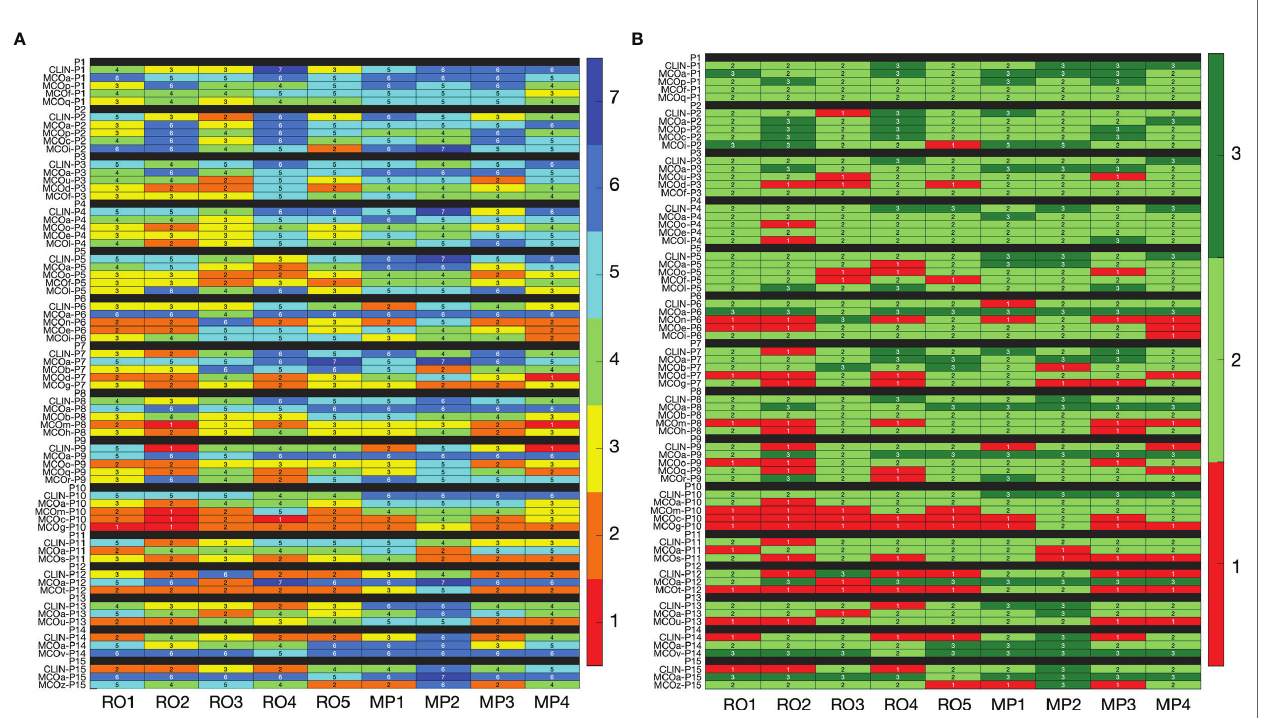
FIGURE 2 | (A) Heatmap visualization for raw plan quality scores (1 – 7, with 7 indicating the highest quality) of the nine observers (x-axis) for all 65 included plans (y- axis). (B) Heatmap visualization for category scores derived from the raw scores. In panel B, the color red indicates that the plan is considered unacceptable (category 1, raw scores 1 and 2), while light and dark green (category 2 with raw scores 3 – 5, and category 3 with raw scores 6 and 7) indicate that the plan is in principle acceptable. In the binary scoring system, red has binary score 0, while both light and dark green have binary score 1. See Section 3.5 for